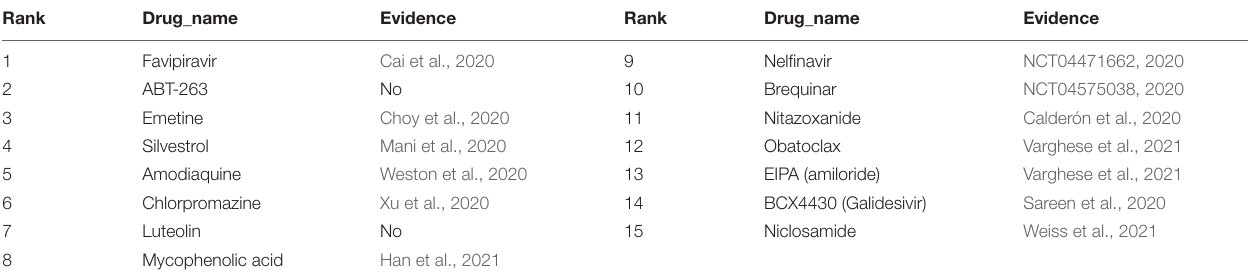
TABLE 6 | Top 15 predicted drugs potentially associated with